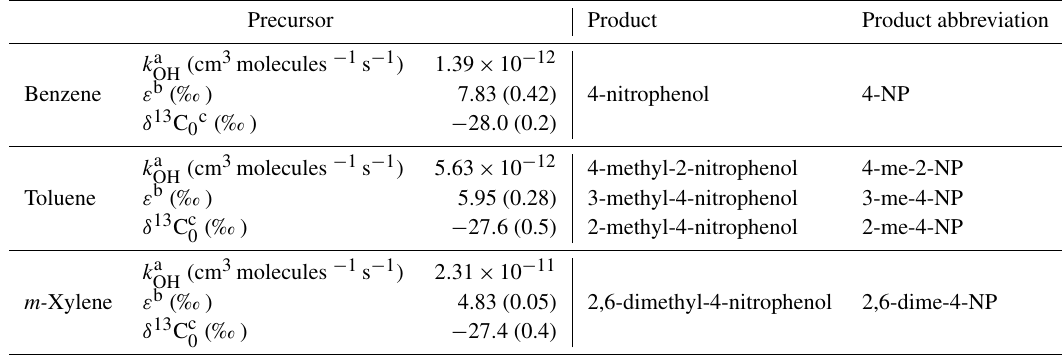
Table 1. Parameters, including the rate constant of the precursor with the OH radical ( k OH ) , the KIE, and the carbon isotope ratio of emissions ( δ 13 C 0 ) used for the determination of the PCA by Eq. (5). The uncertainty of the parameter is given in